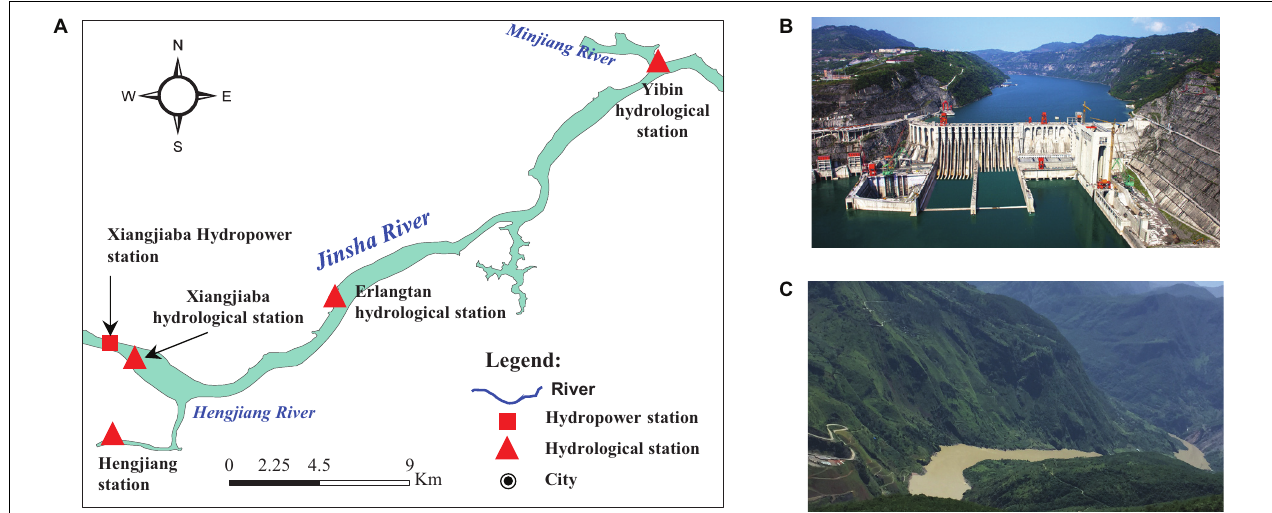
FIGURE 2 | Location of the study area and pictures of the Xiangjiaba Dam and the Jinsha River. (A) Boundary of the hydrodynamic model. (B) Xiangjiaba dam. (C) Lower reaches of the Jinsha